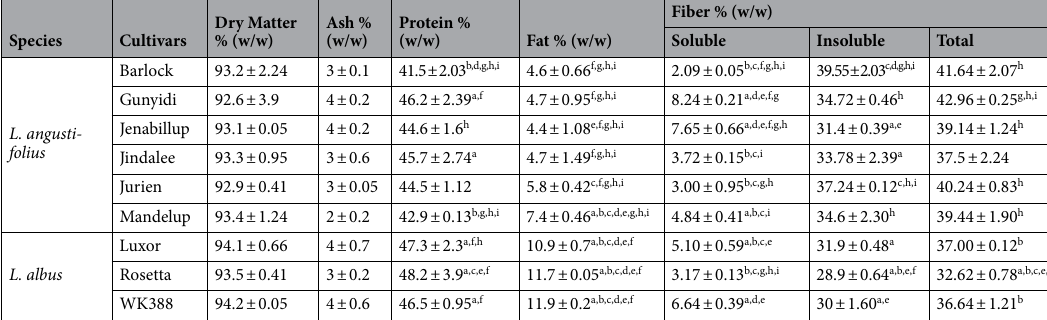
with Rosetta (86.68) having the minimum, and Jurien (87.48) the maximum. For the a* values, a wider range of greenness was observed with Luxor (−3.14) and Jenabillup (−2.31). The b* values also showed yellowness, with WK388 (28.59) the lowest, leading to Rosetta and Barlock (both 31.75) at the high end of the spectrum. Although, significant variation in h° was demonstrated, C* was comparable for all cultivars (see Supplementary Fig. S1 online). Macronutrient composition. Protein, fat and fiber compositions of 9 lupin cultivars are presented in Table 2. Protein content (%, w/w) of the cultivars varied between 41.5% (Barlock) and 48.2% (Rosetta). Substan- tial differences among the fat and fiber content of lupin cultivars were also detected. The lowest fat percentage was demonstrated by Jenabillup (4.4%) and the highest WK388 (11.9%). Soluble fiber content ranged widely from Barlock (2.09%) to Gunyidi (8.24%). Insoluble fiber content varied between 28.9% (Barlock) and 39.55% (Rosetta). Total fiber content was lowest in Rosetta (32.62%) and topped for Gunyidi (42.96%). No substan- tial differences were observed for dry matter and ash content of the lupin cultivars, with values ranging from 92.6% (Gunyidi) to 94.2% (WK388) for dry matter, and from 2% (Mandelup) to 4% (Gunyidi, Jenabillup, Luxor, WK388) for ash. Microelemental composition. Results for the analyses of the 9 lupin cultivars are presented in Table 3. All cultivars demonstrated the presence of the nutritionally important major minerals with highest levels for Na, Mg, P, K and Ca. The trace elements Mn, Fe and Zn were found at generally lower levels than the major minerals. The nutritionally important Co and Se and toxic Cd and Pb were absent from the lupin flours. The presence of Hg was found only in Jenabillup (0.01 mg/kg). Among the major minerals, K was most abundant, with values ranging between 7054.58 mg/kg (Jindalee) and 8697.9 mg/kg (Jenabillup). Phosphorus was the second most abundant element, ranging from 3433.91 mg/kg (Rosetta) to 4327.81 mg/kg (WK388). Magnesium content was between 1307 mg/kg (Barlock) and 1896.92 mg/kg (WK388). The values for Ca were found to be between 590 mg/kg (Barlock) and 1678.43 mg/kg (WK388). The Na content ranged from 176.33 mg/kg (Jindalee) to 456.79 mg/kg (WK388). For the trace element Mn, the L. albus cultivars had the highest content - WK388 (688.58 mg/ kg), Rosetta (796.25 mg/kg) and Luxor (1059.96 mg/kg). For the six L. angustifolius cultivars, the levels of Mn were considerably lower and found to be between 21.64 and 27.31 mg/kg. In the case of Fe, no substantial differ- ences were observed, and the values fluctuated between 21.67 mg/kg (Luxor) and 30.6 mg/kg (Barlock). For Zn, comparable quantities were observed for all, from 25.03 mg/kg (Jurien) to 31.76 mg/kg (Luxor) with the outlier being WK388 (41.97 mg/kg). While considering the quantity of Cu, the values skyrocketed for Jenabillup (42.59 mg/kg). Finally, all the lupin cultivars displayed a little quantity of Mo with values from 0.23 mg/kg (Jurien) to 3.2 mg/kg (Luxor). SDS-PAGE profiling of protein isolates. These can be found as Supplementary Fig. S3 online. From the electrophoretic pattern it can be extrapolated that, β-conglutin, the major globulin component of the lupin cultivars, is formed from 10–12 major types of subunit (15–72 kDa); α-conglutin is composed of four main types of subunit (53, 60, 66, and 70 kDa), as well as a number of minor subunits; γ-conglutin, a minor globulin compo- nent, is composed of one main type of subunit (42–43 kDa) containing two polypeptide chains. Moreover, below 80 kDa, the bands of six L. angustifolius cultivars were very similar. Jenabillup, Jurin and Mandelup showed few large proteins and peptides. On the other hand, two L. albus cultivars, Luxor and Rosetta, demonstrated a total band similarity. Pasting properties. Pasting properties of the lupin flours were measured by a Rapid Viscosity Analyzer (RVA) and the results are shown in Fig. 1 and Supplementary Table S2 online. Peak 1 represents the maximum viscosity attained in the heating phase of RVA analysis and the values ranged from 122.5 mPa-s (Rosetta) to 688